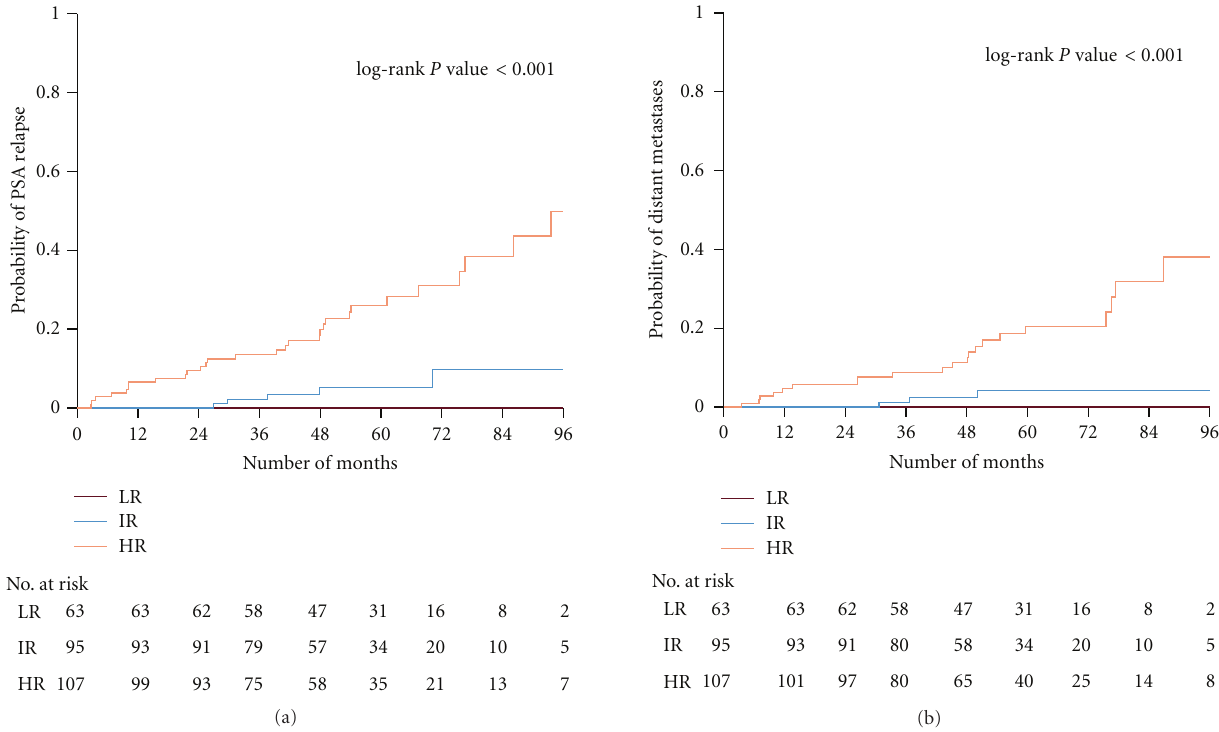
Figure 3: The probability of PSA-relapse (panel a) and developing distant metastases (panel b) according to risk groups is presented. The number of patients at risk is shown at di ff erent time intervals. LR: low risk, IR: intermediate risk, HR: high